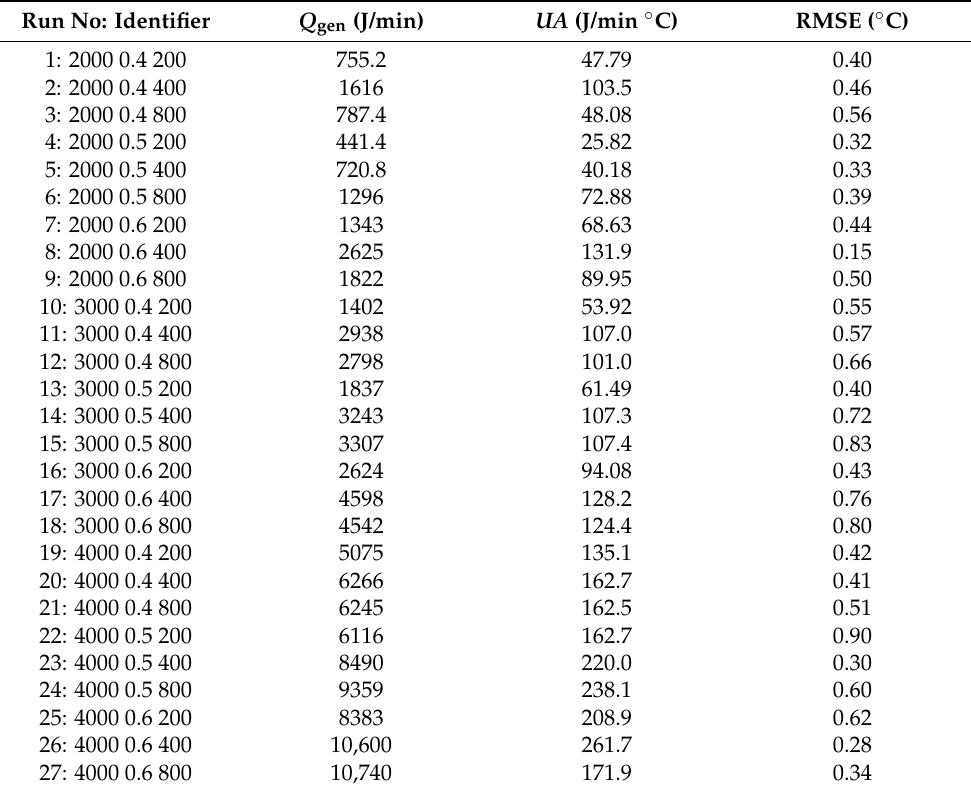
Table 2. Fitted parameters of the LPM and associated statistics for the training runs.